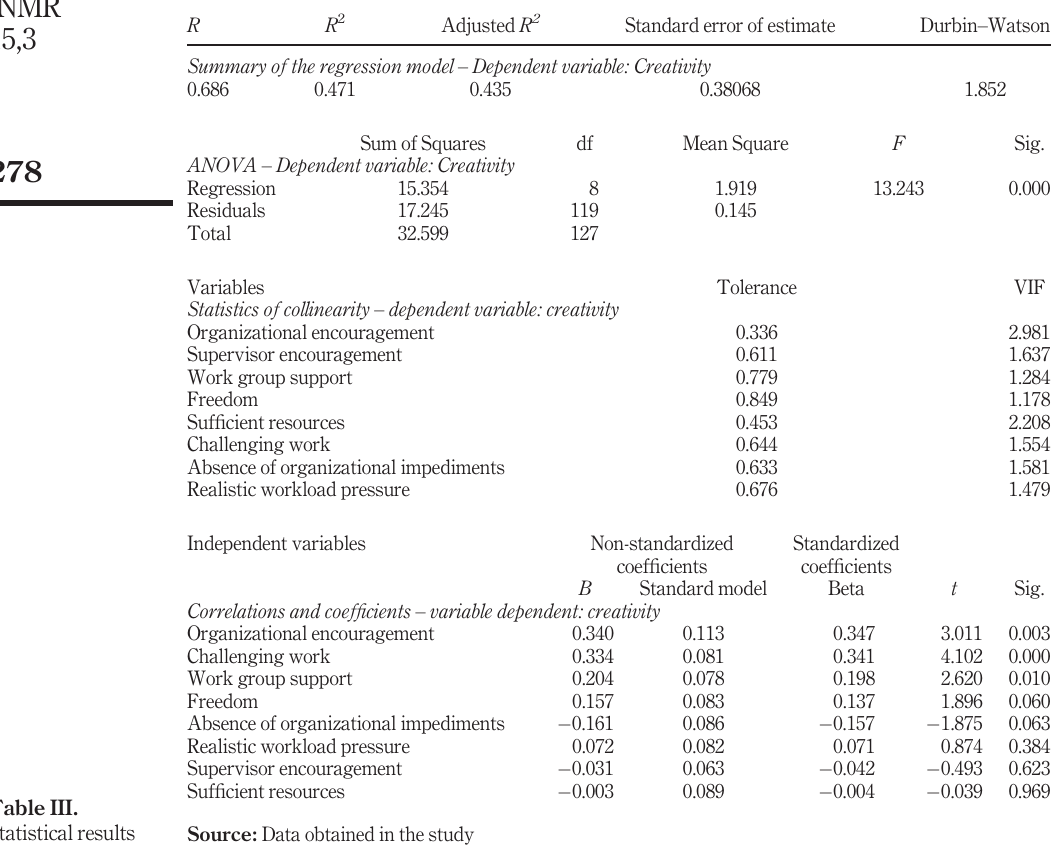
Table III. Statistical